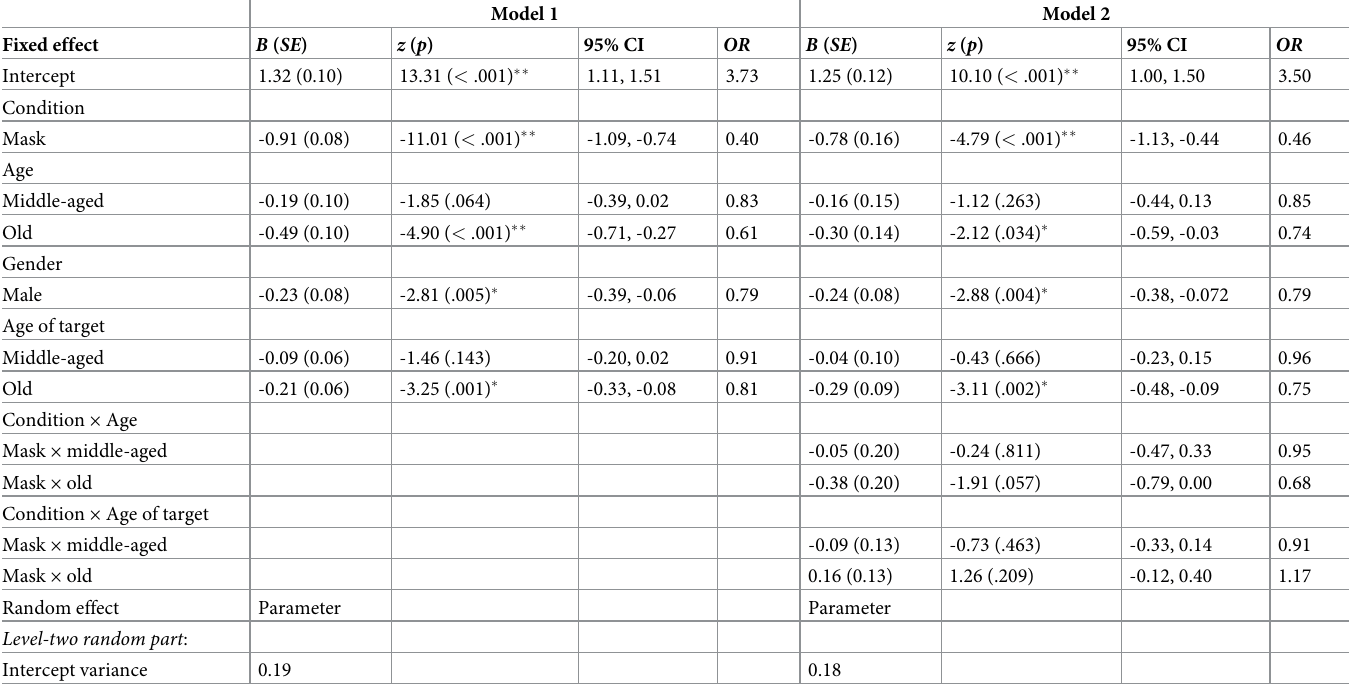
Table 2. Multilevel logistic regression models capturing the effect of condition, age, gender, and age of target on emotion-recognition